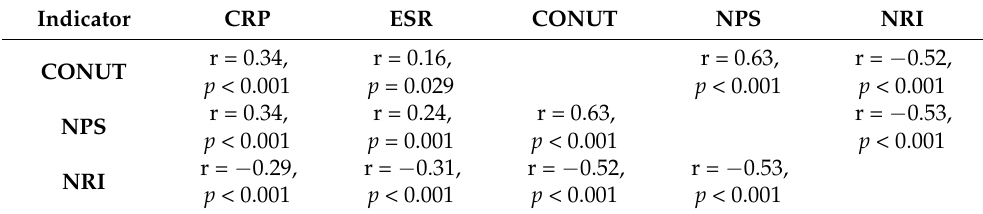
Table 2. Correlation of nutritional scores with indicators of systemic inflammation or other nutritional